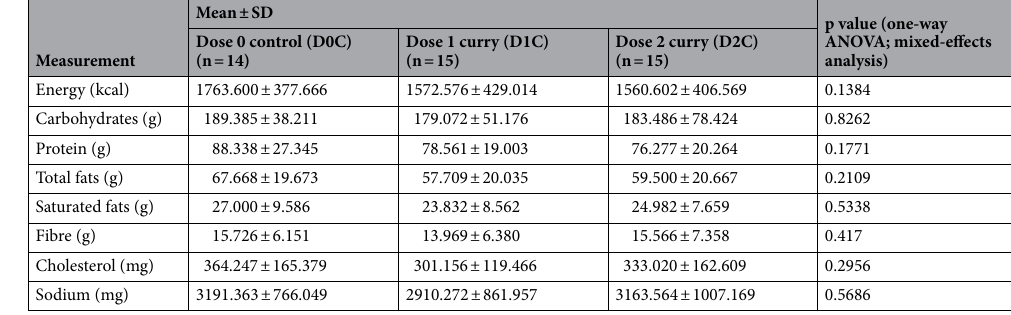
Table 1. Mean daily intake of energy and nutrients during the run-in periods prior to each intervention session. P values were calculated from the statistical test of one-way ANOVA based on the consumption of each nutrient. D0C = Meal with no spices intervention, D1C = Meal with low (6 g) mixed spices intervention, D2C = Meal with high (12 g) mixed spices intervention, n = 15 each intervention, except for D0C, where the data from 1 subject was excluded because of being an outlier (extreme